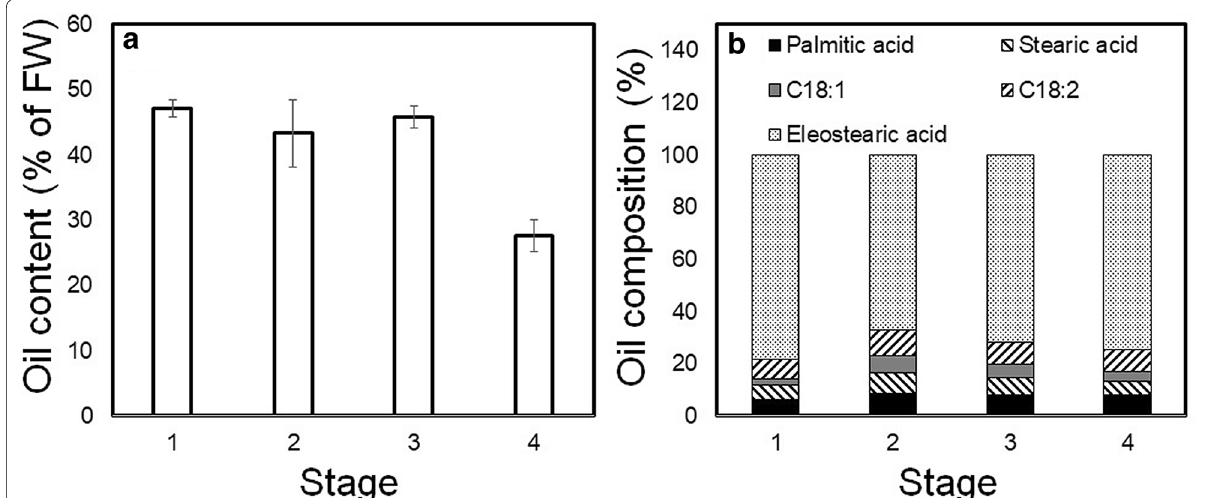
Fig. 5 Oil content ( a ) and oil composition ( b ) observed in the endosperm in the different developmental stages. The data represent the mean of four independent measurements (mean SE). Stage 1 (immature green): green fruits about 4.5 cm in diameter, 4 months after anthesis. Stage 2 ± (mature green): green fruits about 6 cm in diameter, 5 months after anthesis. Stage 3 (turning): red‑brown fruits about 6 cm in diameter, 5 months after anthesis. Stage 4 (over ripe): brown fruit about 6 cm in diameter, 5 months after